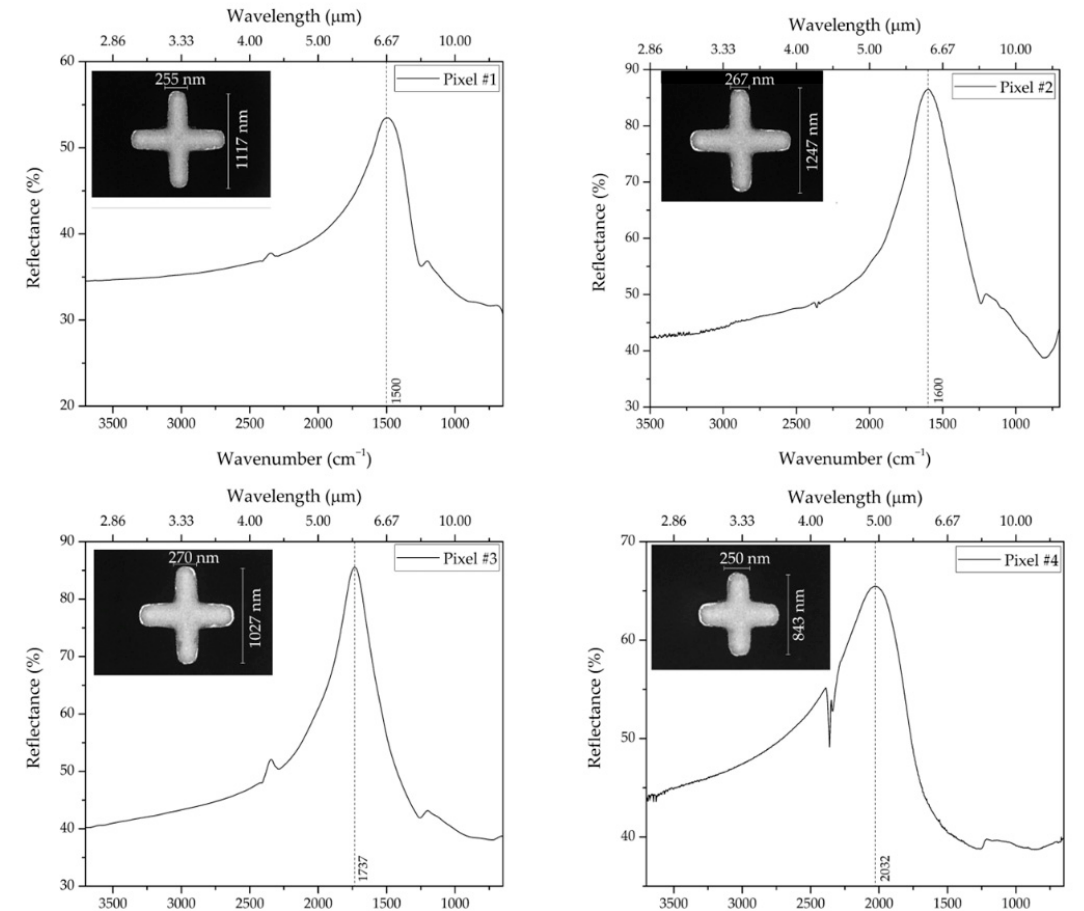
Figure 6. Experimental reflectance responses pertaining to all pixels for naked NAs (no molecules adsorbed); each inset shows the corresponding NA SEM image and dimensions.